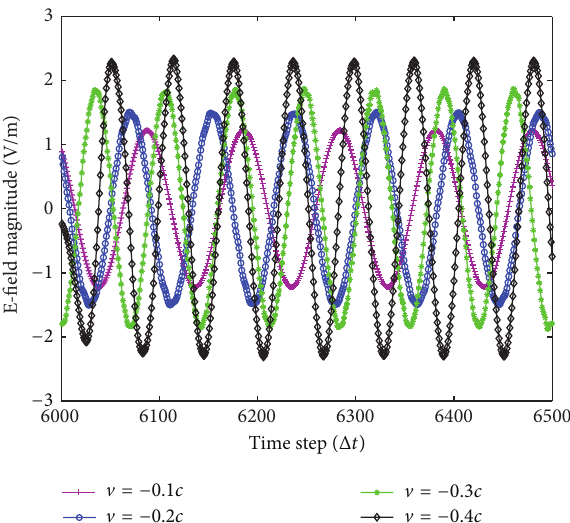
Figure 6: Time-domain scattered waveforms of the conducting surface moving along the −𝑧 -axis.